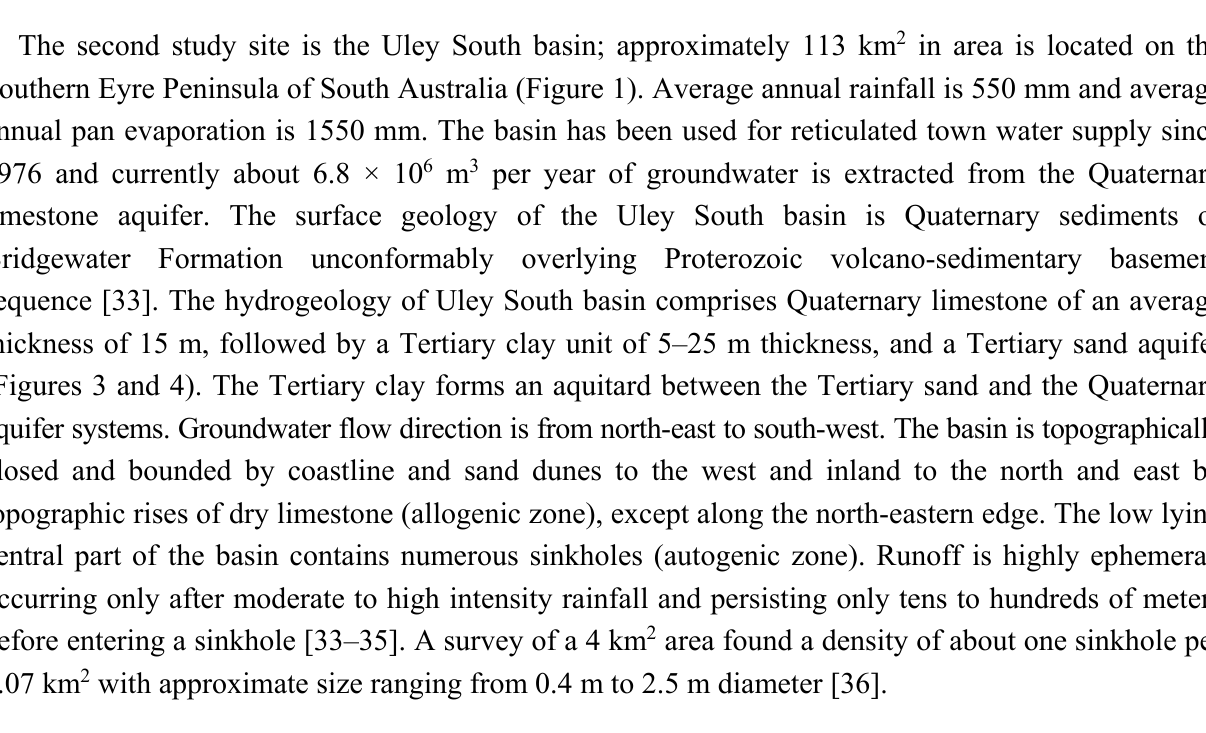
Figure 3. Sinkholes in Uley South basin ( a ) Surveyed sinkholes ( b ) View of a sinkhole in a natural